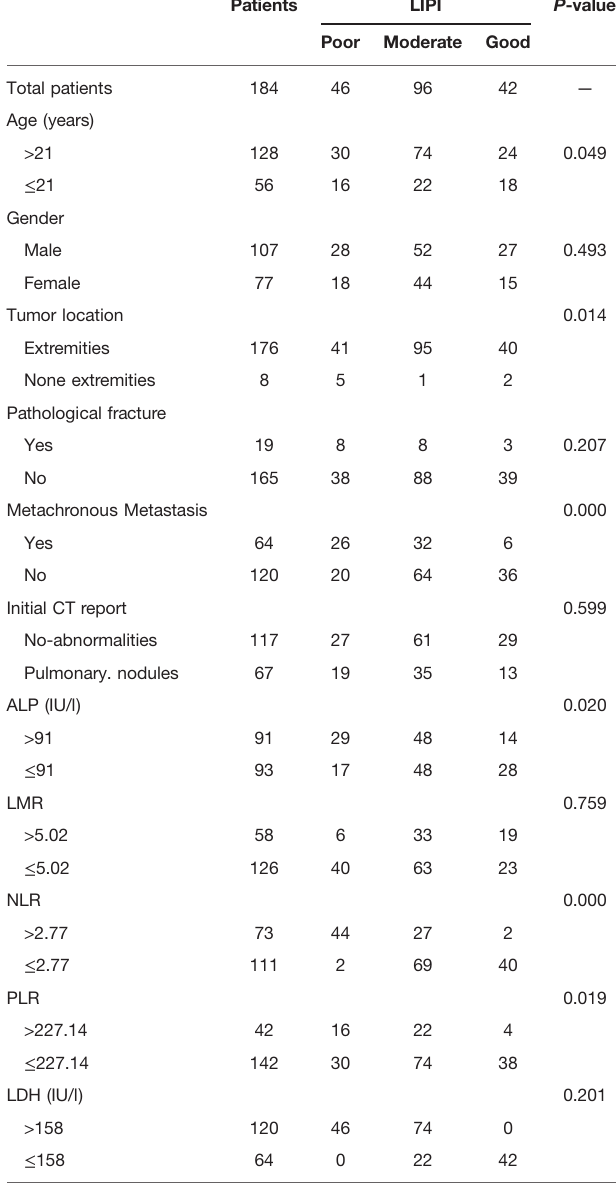
LIPI, lung immune prognostic index; Initial CT report, initial computed tomography report; ALP, alkaline phosphatase; LMR, lymphocyte – monocyte ratio; NLR, neutrophil – lymphocyte ratio; PLR, platelet – lymphocyte ratio; LDH, lactate